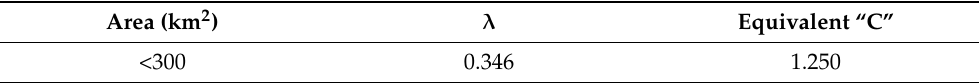
Table 5. Adopted Giandotti’s reduction coefficient (Source: [31]).